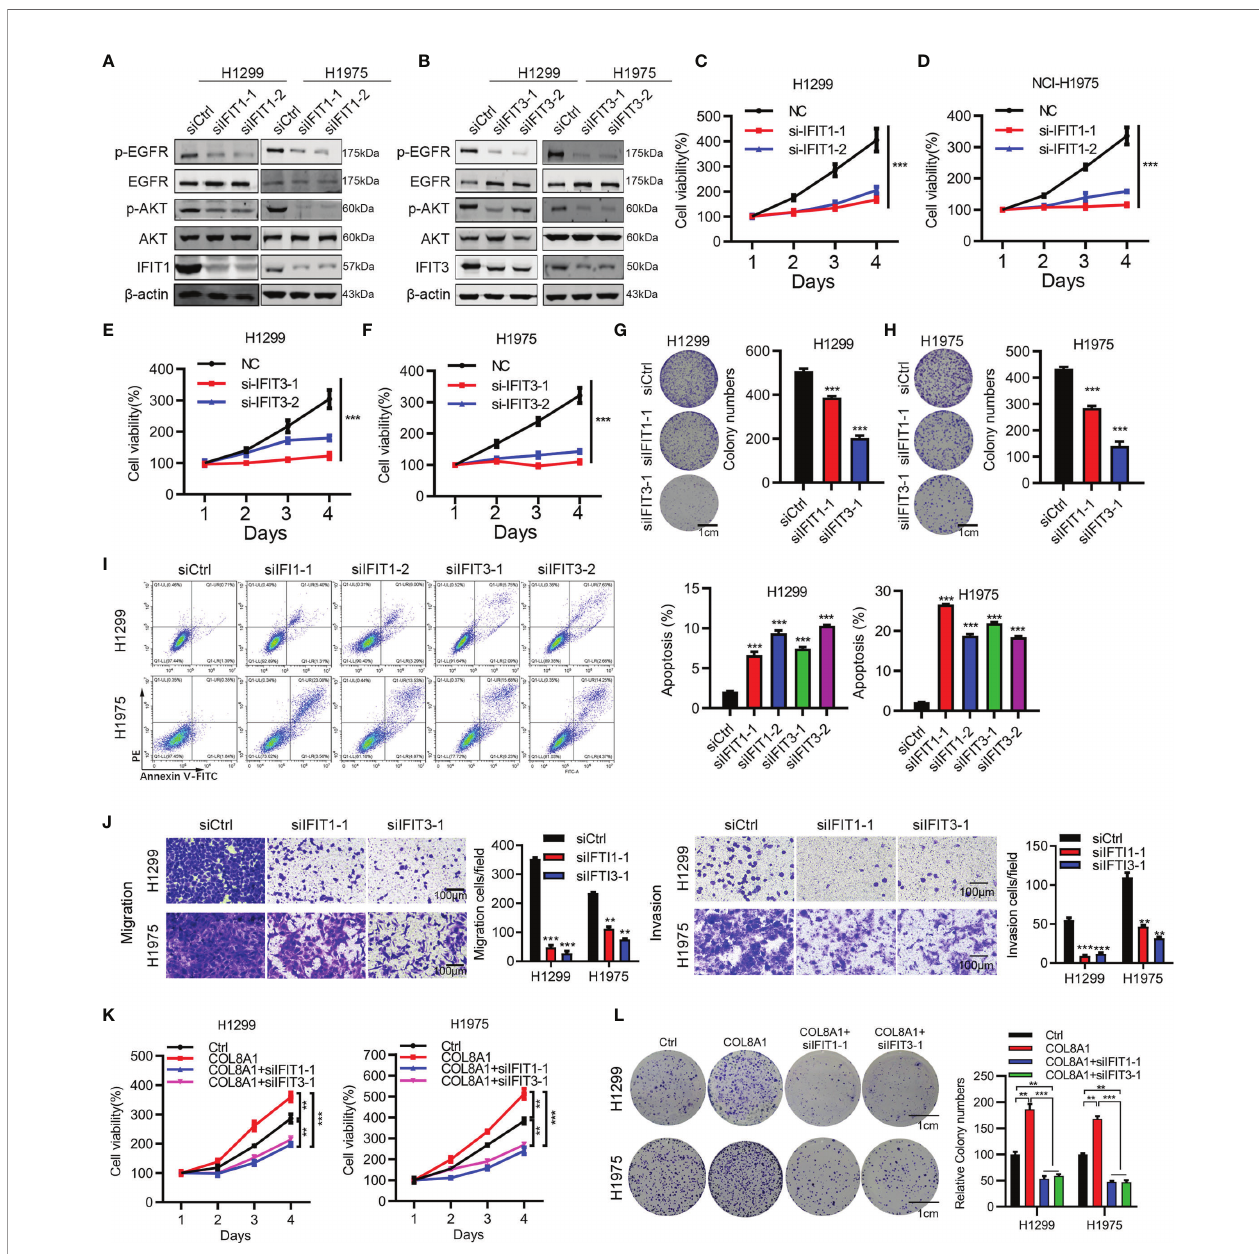
FIGURE 5 | IFIT1 and IFIT3 knockdown effectively suppresses proliferation, migration, and apoptosis of NSCLC cells. (A, B) Effects of IFIT1 and IFIT3 knockdown on EGFR and AKT activity determined by western blotting. (C, D) Cell viability assays performed in IFIT1-knockdown H1299 and H1975 cells. (E, F) Cell viability assays performed in IFIT3-knockdown H1299 and H1975 cells. (G, H) Colony formation assessed in siCtrl-, siIFIT1-1, and siIFIT3-1-treated H1299 (G) and H1975 (H) cells. (I) Effects of IFIT1 and IFIT3 knockdown on apoptosis assessed by fl ow cytometry. (J) Effects of IFIT1 and IFIT3 knockdown on cell invasion and migration assessed by transwell assay. (K, L) H1299 and H1975 cells transfected with COL8A1, siIFIT1, and siIFIT3 were subjected to cell viability (K) and colony formation analysis (L) . **p < 0.01. ***p <